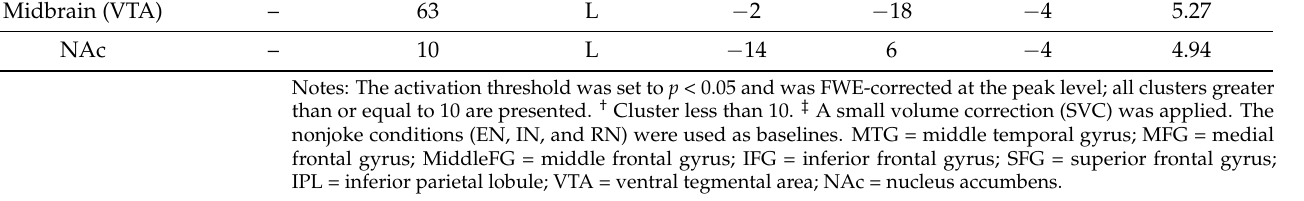
MNI Coordinates